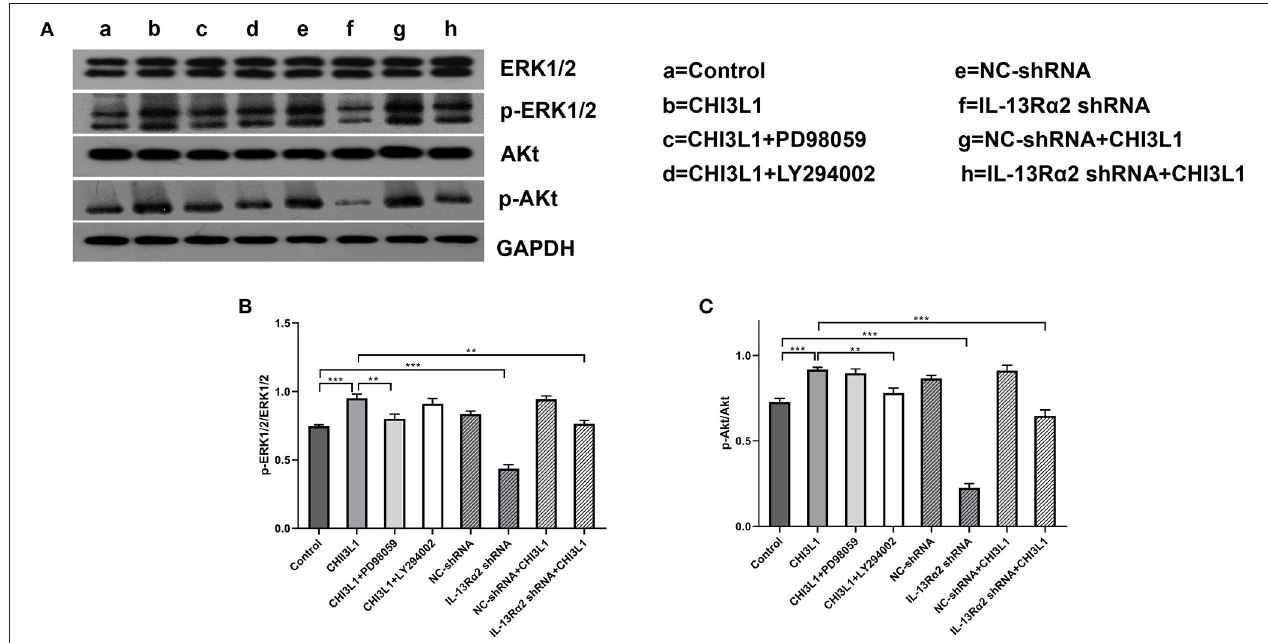
FIGURE 6 | Western blot analysis of ERK and AKT in HUVECs. CHI3L1 prompted the phospho-ERK and phospho-AKT expression of HUVECs, and IL-13R α 2 shRNA decreased expression of phospho-ERK and phospho-AKT (A) . The expression ratio of phosphorylated ERK and AKT to total ERK and AKT was determined by densitometric analysis (B,C) . Data were presented as mean ± SD ( n = 3 per group), ** p < 0.01 and *** p <